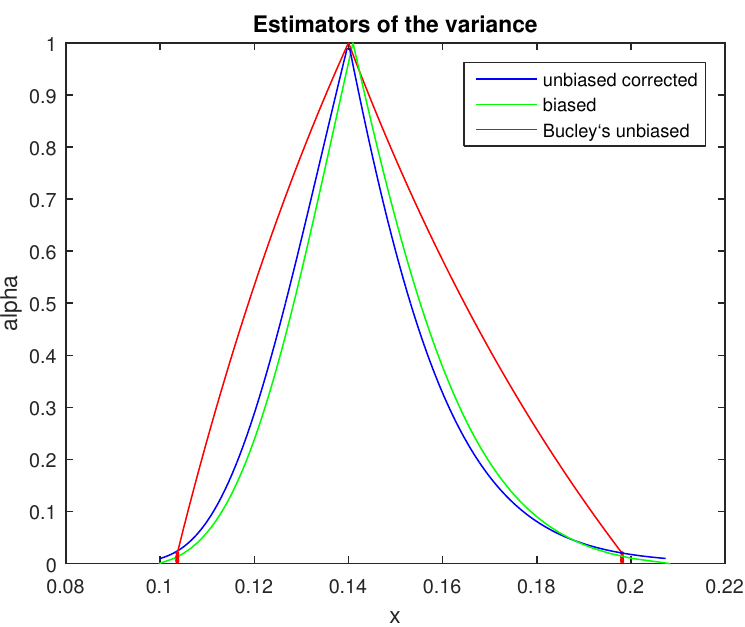
Figure 3. Non-asymptotic fuzzy estimators of the variance σ 2 : correct unbiased (blue line), biased (green line), unbiased used in [29] (red